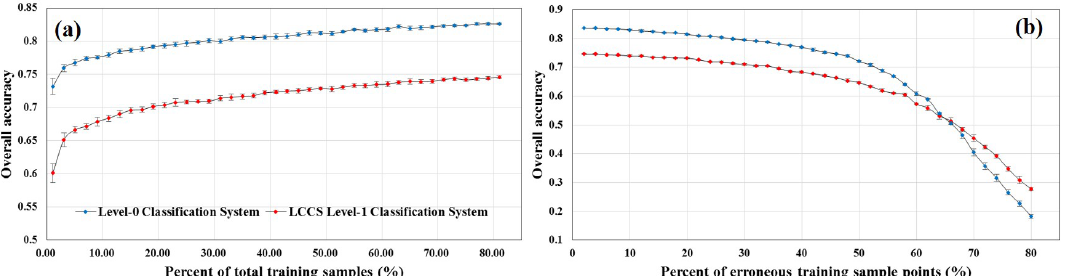
Figure 10. Sensitivity analysis showing the relations between the overall classification accuracy and the percentage of total samples and erroneous sample